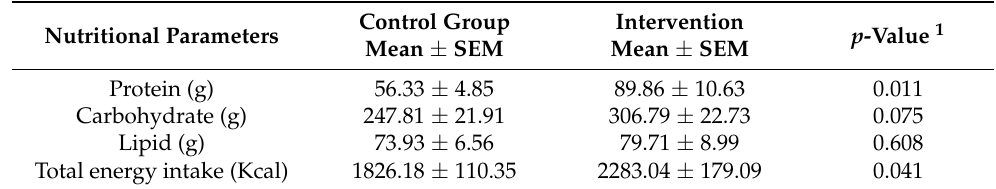
Table 2. Mean values of total protein (g), carbohydrate (g), lipid (g), and energy intake on the day before intervention in control and intervention groups (n = 12, each group).